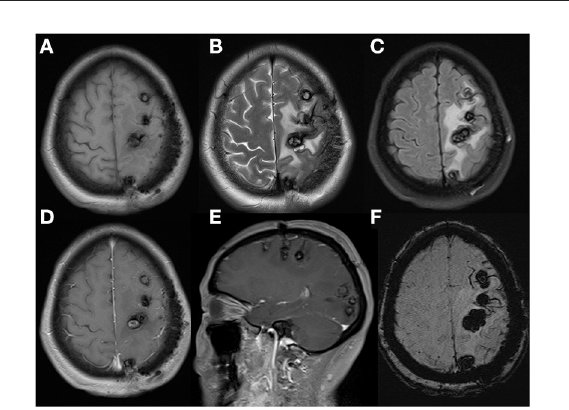
FIGURE5 Cerebral MRI re-examination in postoperative 8 months demonstrated cerebral lesions had increased in quantity and size, especially in occipital lobe, with peripheral enlarged edema and mild inner gadolinium enhancement in the largest lesion located in frontal lobe. Axial T1WI (A) , axial T2WI (B) , FLAIR (C) , axial (D) , sagittal (E) , enhanced T1WI and axial SWI (F) .